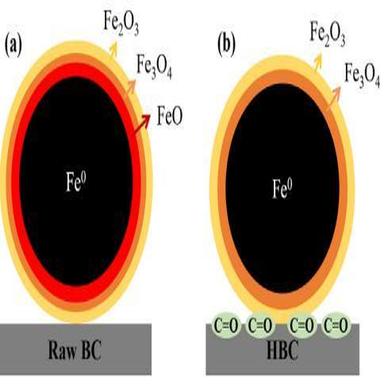
Schematic of the different core-shell layers for nZVI particles on (a) raw BC, and (b) HBC.